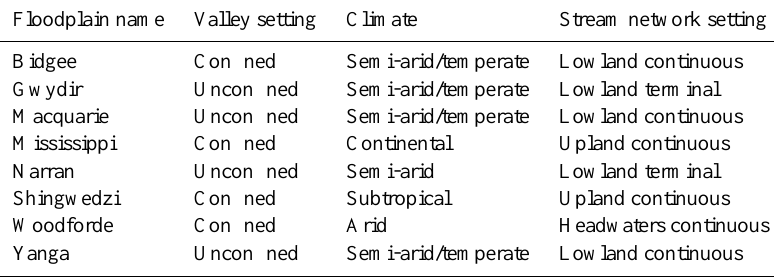
Table 1. Summary of the geographical and climatic settings of the eight study floodplains.